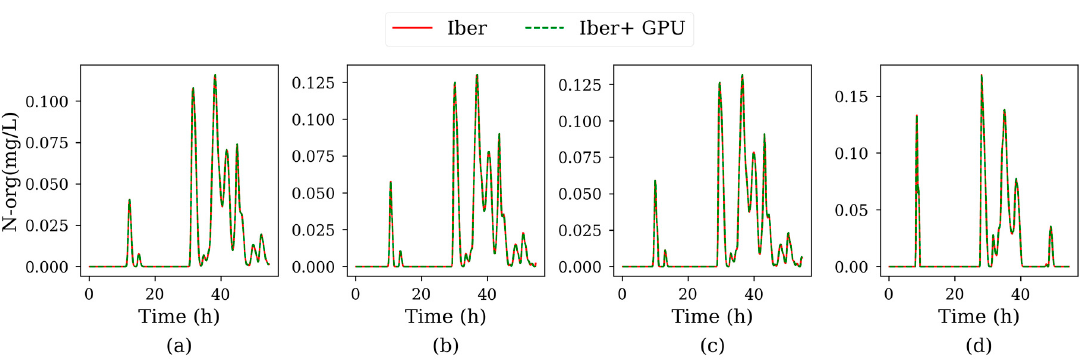
Figure A3. Time series of organic nitrogen for Test 3, sampled at control points P1 ( a ), P2 ( b ), P3 ( c ) and 4 ( d ).